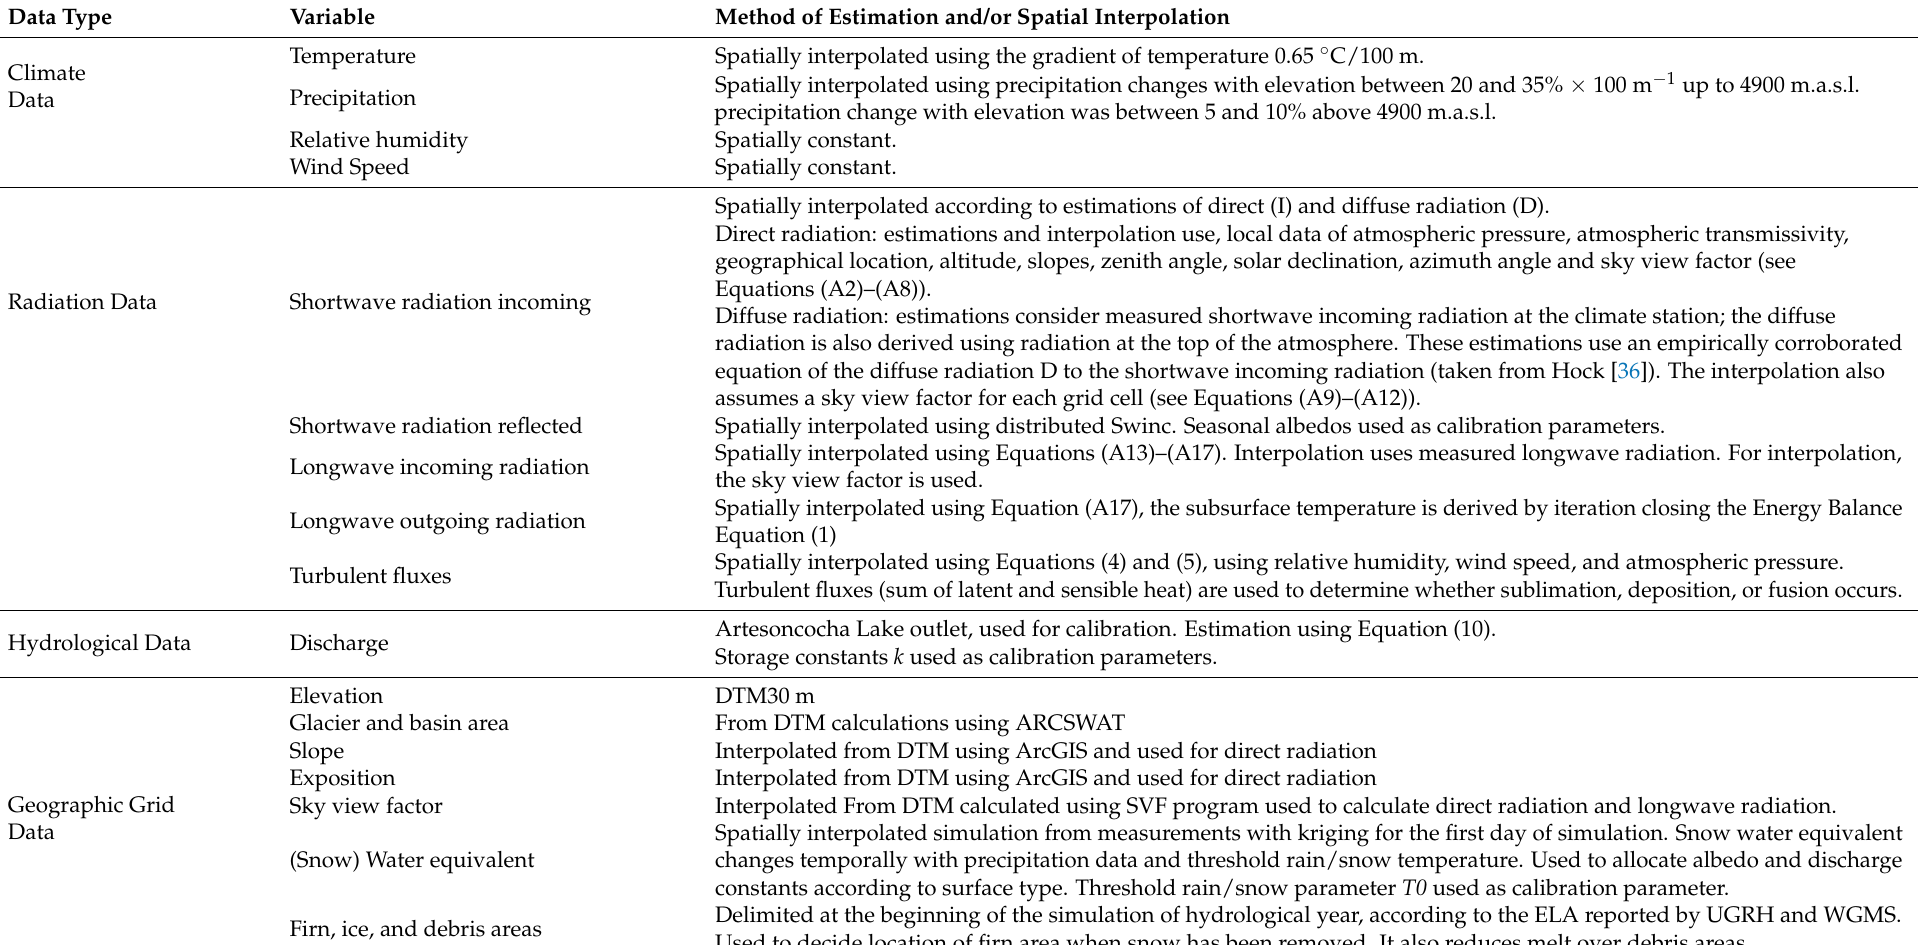
Table 2. DEBAM input variables and methodology of their estimation across the glacier model